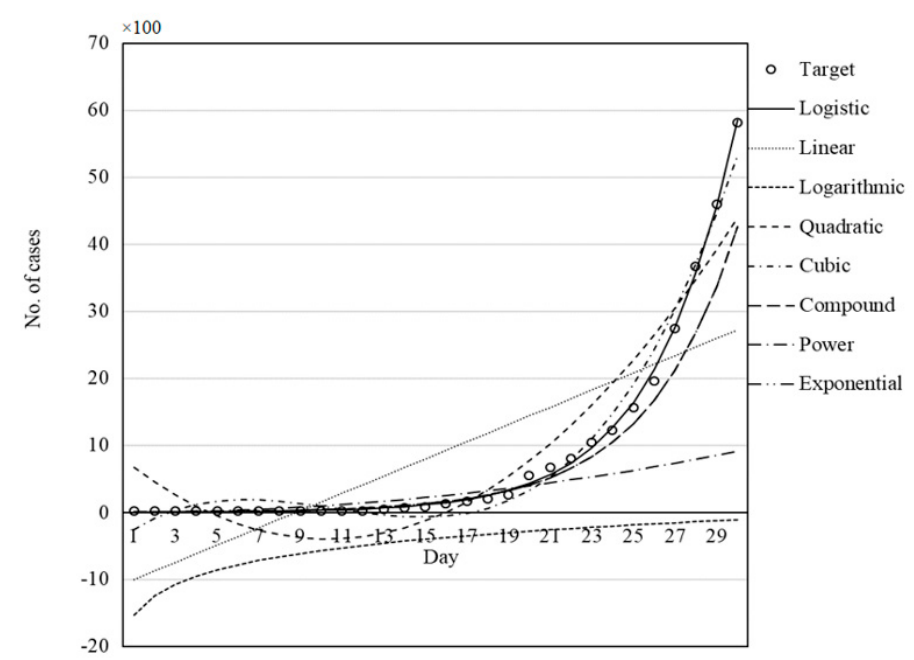
Figure 10. Set of models for Germany fitted by GWO.